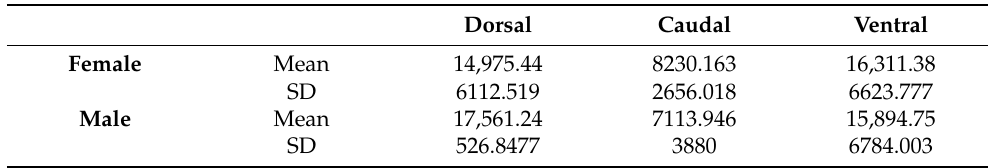
Table 3. Centroid size and standard deviations of quails.